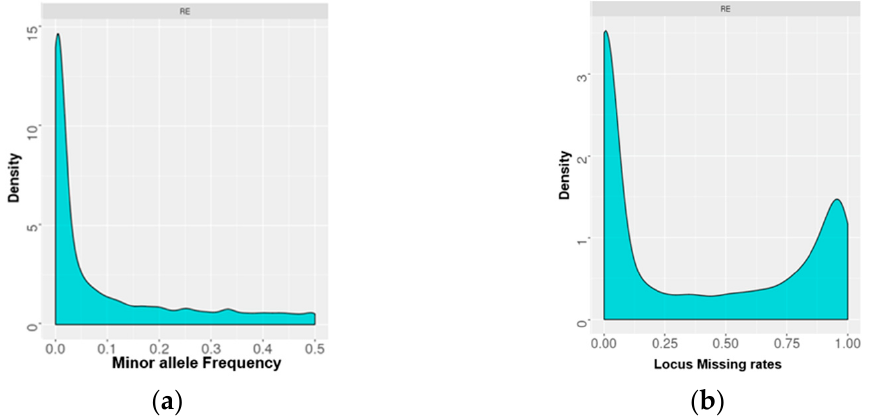
Figure 1. ( a ) Minor allele frequency and ( b ) locus missing rates in the genomes of Rhanterium eppoposum genotypes of Kuwait.